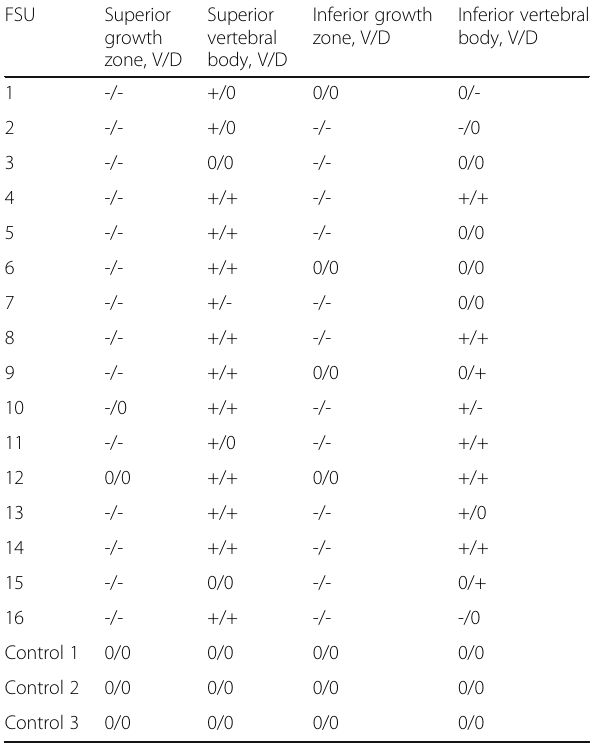
Table 2 MRI signal of the vertebral bodies of the loaded FSUs FSU